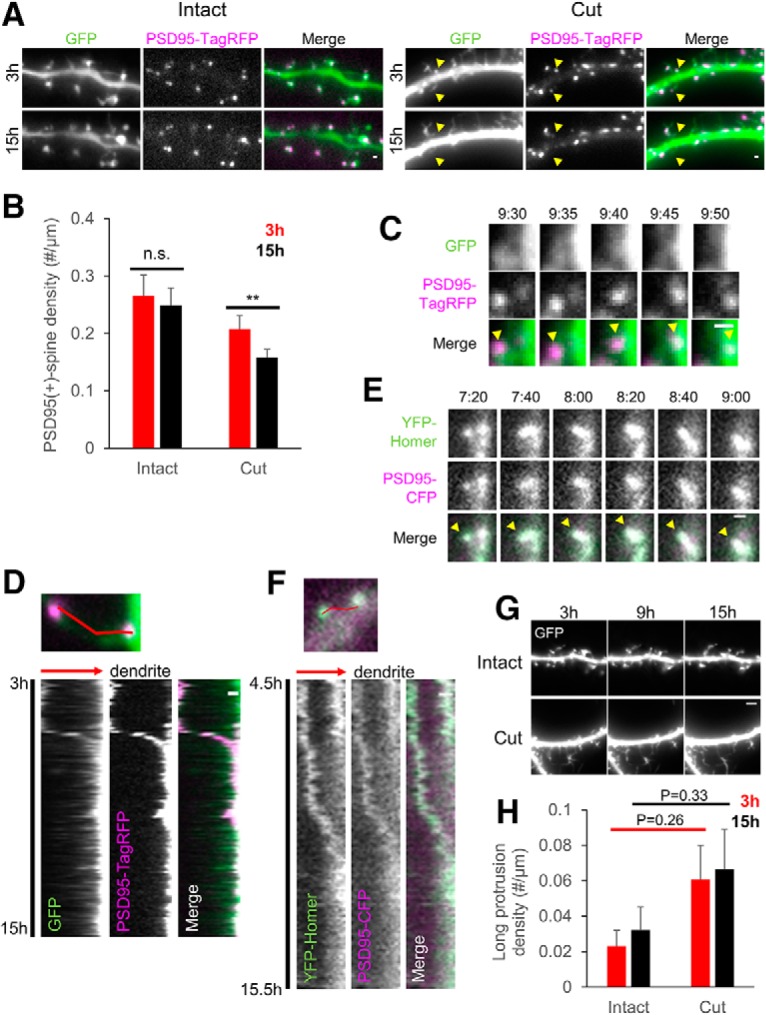
Temporal changes in PSD-95-positive spines after afferent elimination. A, Time-lapse images of dendrites with or without afferent elimination 3 and 15 h after manipulation. GFP, PSD-95-TagRFP, and their merged images (GFP; green, PSD-95-TagRFP; magenta) from left to right, respectively. Yellow arrowheads indicate loss of PSD-95-positive spines. B, Densities of PSD-95-positive spines 3 and 15 h after afferent elimination. C, Representative time-lapse sequences of a PSD-95-TagRFP cluster moving toward a dendritic shaft. The upper row shows time-lapse images of GFP. The middle row shows time-lapse images of PSD-95-TagRFP. The lower row in C is merged images of GFP (green) and PSD-95-TagRFP (magenta) with yellow arrowheads indicating translocating clusters. D, The top image shows a PSD-95-TagRFP cluster in the spine before moving. Along a red line in the image, the kymograph was generated. Each column in the kymograph shows the images of GFP, PSD-95-TagRFP or merged images of GFP (green) and PSD-95-TagRFP (magenta) from left to right, respectively. The kymographs start and end at 3 and 15 h after afferent elimination. The direction of the dendritic shaft is indicated by a red arrow. E, Representative image sequences of YFP-Homer1c (top) and PSD-95-CFP (middle) clusters moving together toward a dendritic shaft, together with an overlay of YFP-Homer1c (green) and PSD-95-CFP (magenta). Yellow arrowheads indicate a translocating cluster. F, The top image shows YFP-Homer1c and PSD-95-CFP clusters before moving. Along a red line in the image, kymographs were created. Each column in the kymographs shows YFP-Homer1c, PSD-95-CFP or overlay of YFP-Homer1c (green) and PSD-95-CFP (magenta) from left to right, respectively. The kymographs start and end at 4.5 and 15.5 h after afferent elimination. Direction toward the dendritic shaft is indicated by a red arrow. G, Time-lapse imaging of GFP-expressing dendrites with or without afferent elimination at 0 h and subsequent data acquisition at 3, 9, and 15 h. H, Density of dendritic protrusions classified as long protrusions (>4 µm in lengths) at 3 and 15 h after afferent elimination. Error bars are SEM; **p < 0.01, n.s. = not significant. Scale bars = 1 μm (A, C–F), 4 μm (G). Methods for axon-preserving alternate afferent axon elimination can be found in Extended Data Figure 4-1, and Results from alternate afferent axon elimination can be found in Extended Data Figure 4-2.